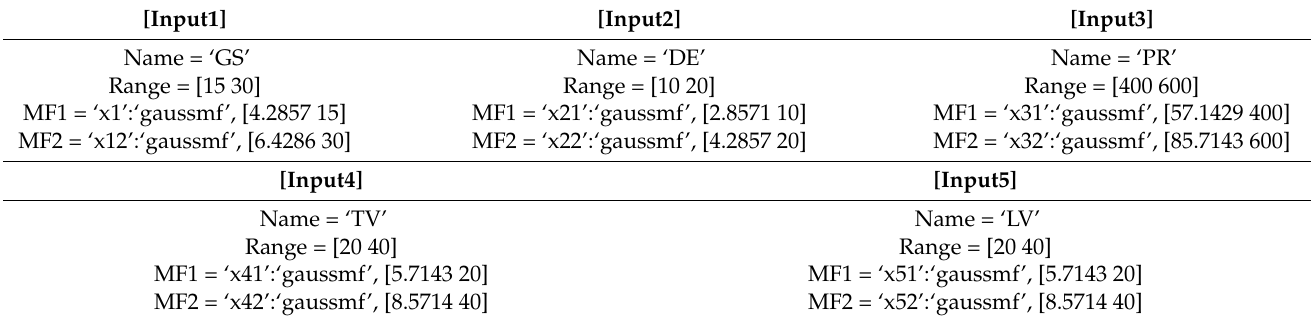
Table 3. Values of the membership functions employed to develop the